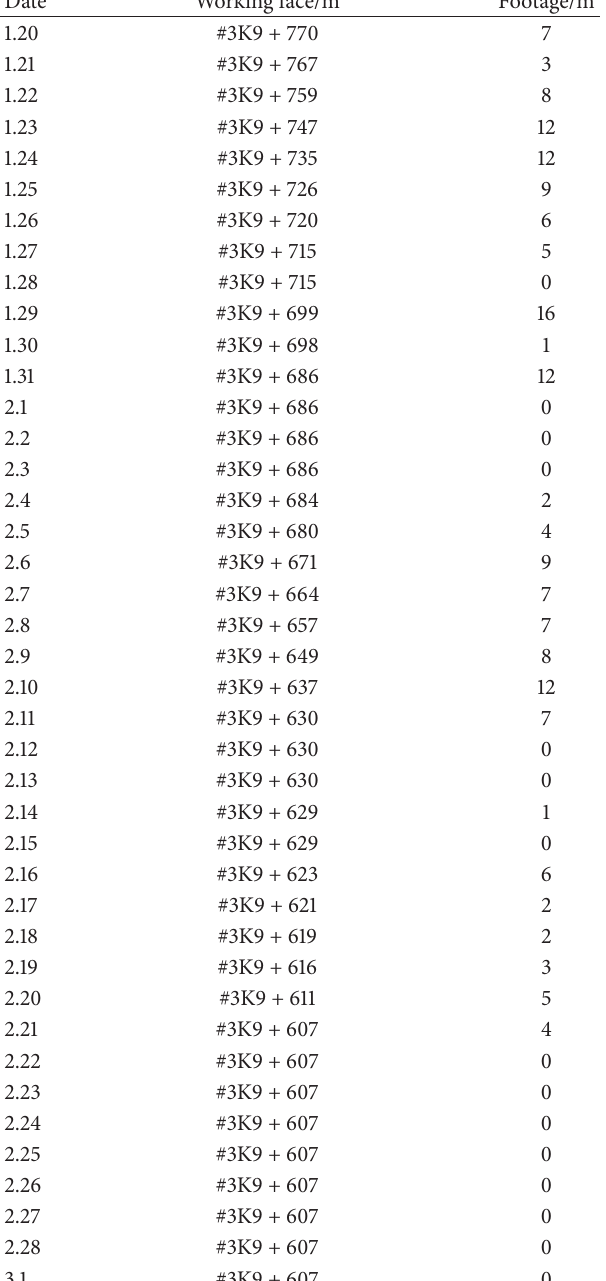
Table 2: Daily footage of TBM tunneling in diversion tunnel #3 (January 20 to March 1, 2011).